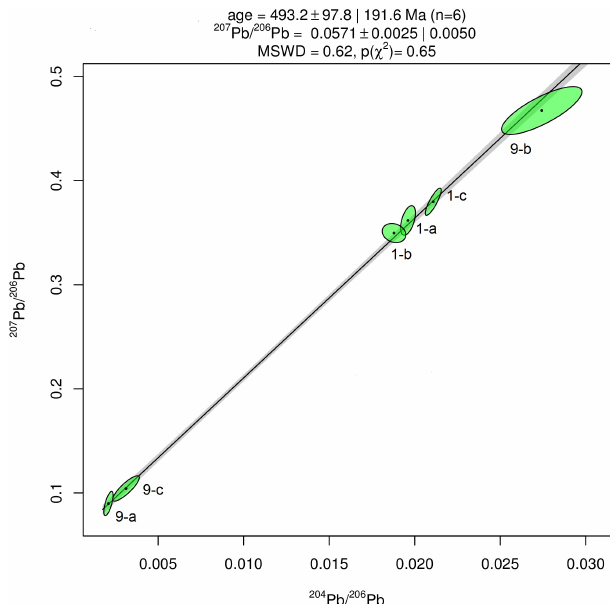
Figure 14. Results of Pb–Pb age determination of kerite from Volyn pegmatite. The reference line corresponds to an age of 493 . 2 ± 97 . 8Ma (1 σ ). The large uncertainty is mainly due to very small amounts of Pb in the samples, resulting in poor ion counting statis- tics in mass spectrometry. Data were plotted and age calculated us- ing the program IsoplotR (Vermeesch,